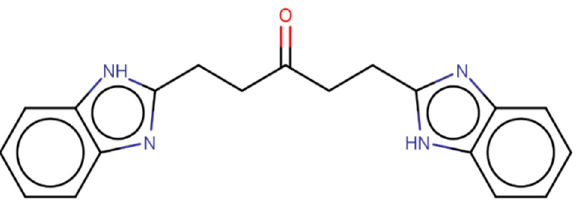
Figure 3. The 2D chemical structure of ZINC390718, C 19 H 18 N 4 O, with nitrogen groups (blue) and carbonyl (red) highlighted.